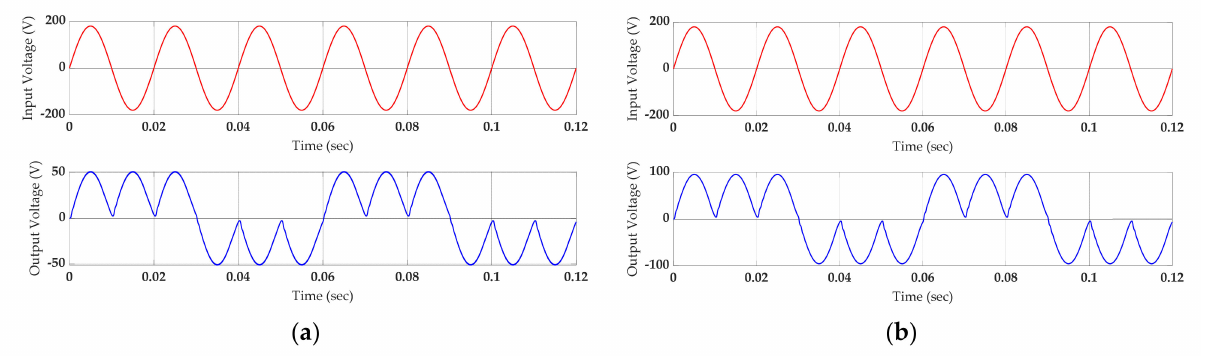
Figure 7. Simulation results for output frequency step-down process with a voltage gain of ( a ) 0.28; ( b )